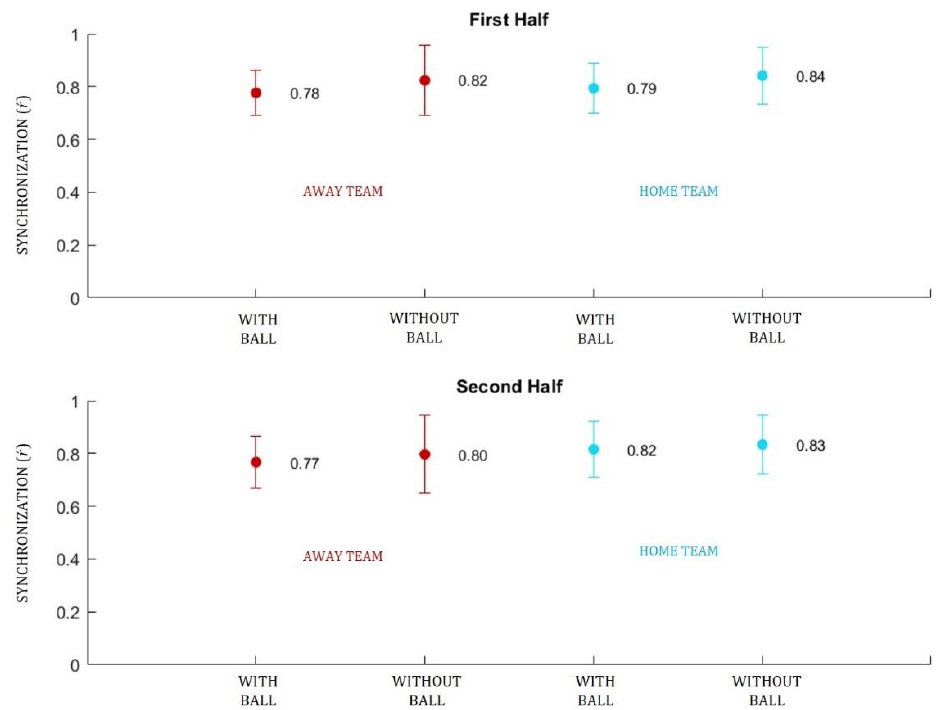
Figure 2. Mean and standard deviation (SD) of the synchronization ( 𝑟́ ) values per team, in the two halves of the match and by ball possession. Values in red represent the away team, values in blue represent the home team.